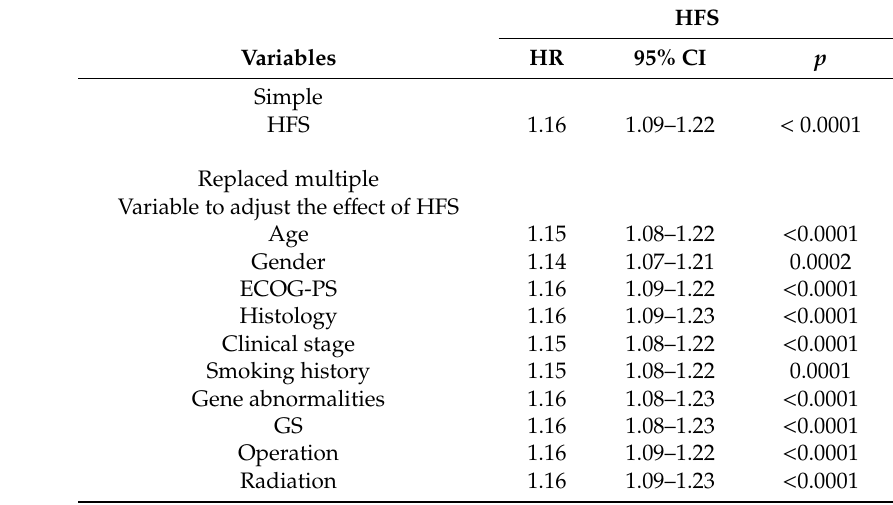
Table S1. Although previous radiotherapy did not confer a risk for anti-cancer drug-induced pneumonia (Table 2A), 10 of 19 these patients had received radiotherapy. The development of radiological interstitial abnormalities in the ten patients did not correspond to the exposure to radiation. The HFS did